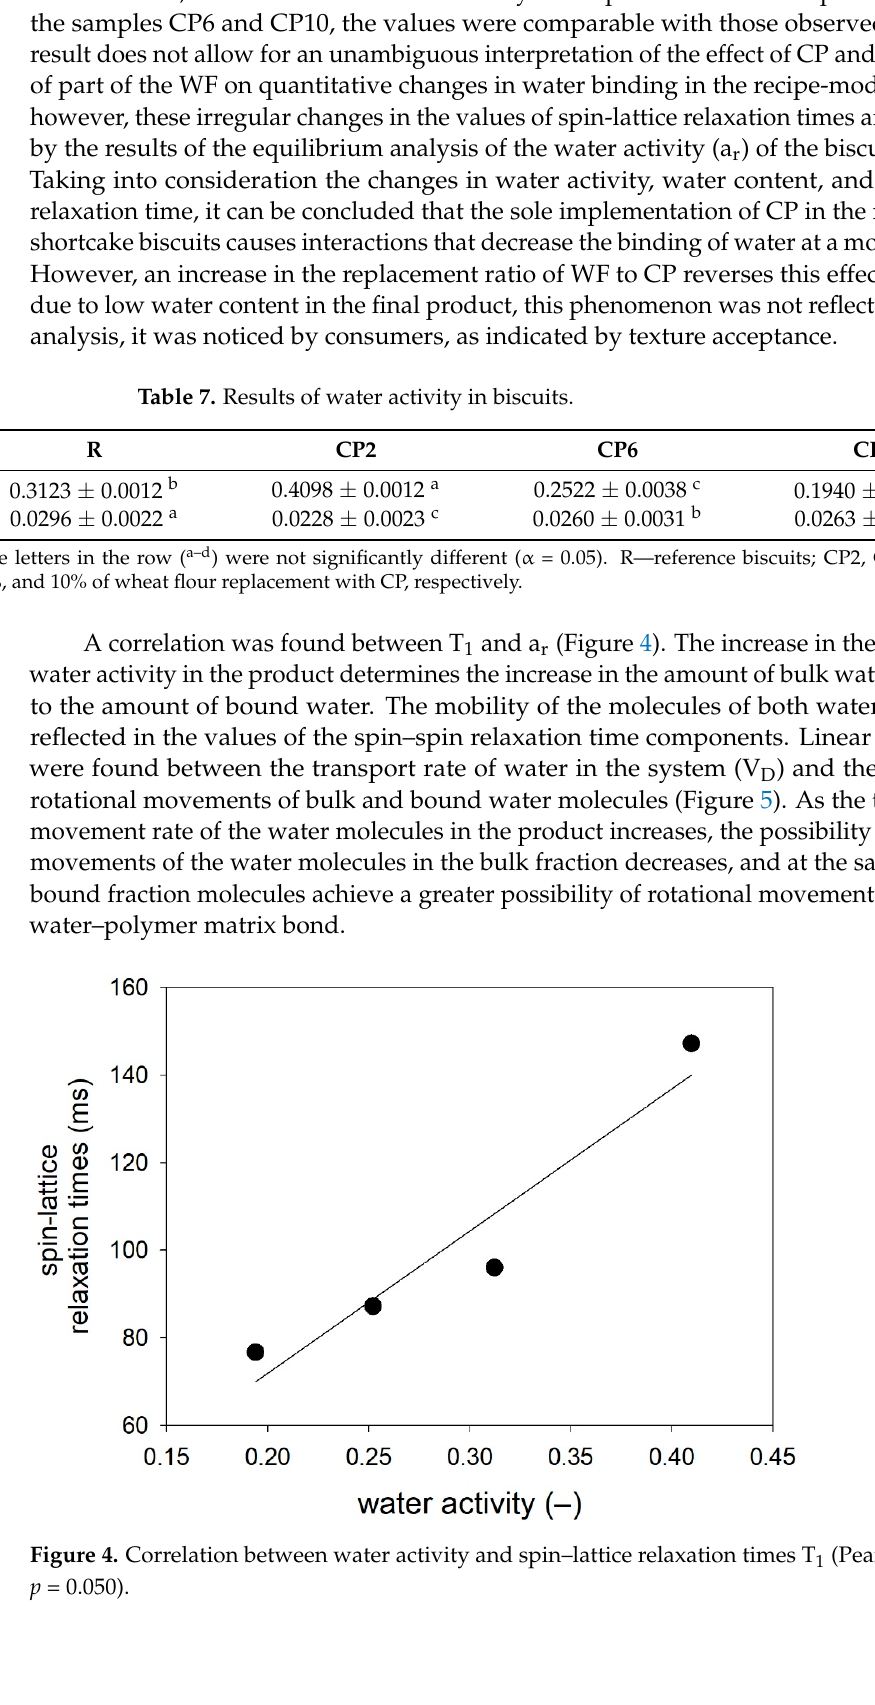
Figure 5. Linear correlation between transport rate (V D ) and short (T 21 ) and long components (T 22 ) of the spin–spin relaxation times. (Pearson r = -0.849; p = 0.076 and r = 0.801; p = 0.100 for T 21 and T 22 , respectively). 3. Materials and Methods 3.1. Shortcake Biscuits Manufacturing The recipe for reference biscuits (denoted as R in the text) was as follows: 200 g wheat flour (type 500) (GoodMills Polska sp. z o.o., Grodzisk Wielkopolski, Poland), 64 g white sugar (Pfeifer & Langen Polska S.A., Ś roda Wielkopolska, Poland), 20 g brown sugar (Pfeifer & Langen Polska S.A., Ś roda Wielkopolska, Poland), 2 g milk powder (SM Mlekovita, Wysokie Mazowieckie, Poland), 2.5 g salt (Kopalnia Soli ‘K ł odawa’ S.A., K ł od- awa, Poland), 2 g baking powder (Dr. Oetker Polska Sp. z o.o., Gda ń sk, Poland), 80 g baking margarine (Upfield Polska sp. z o.o., Warsaw, Poland), and 44 g water. In the test